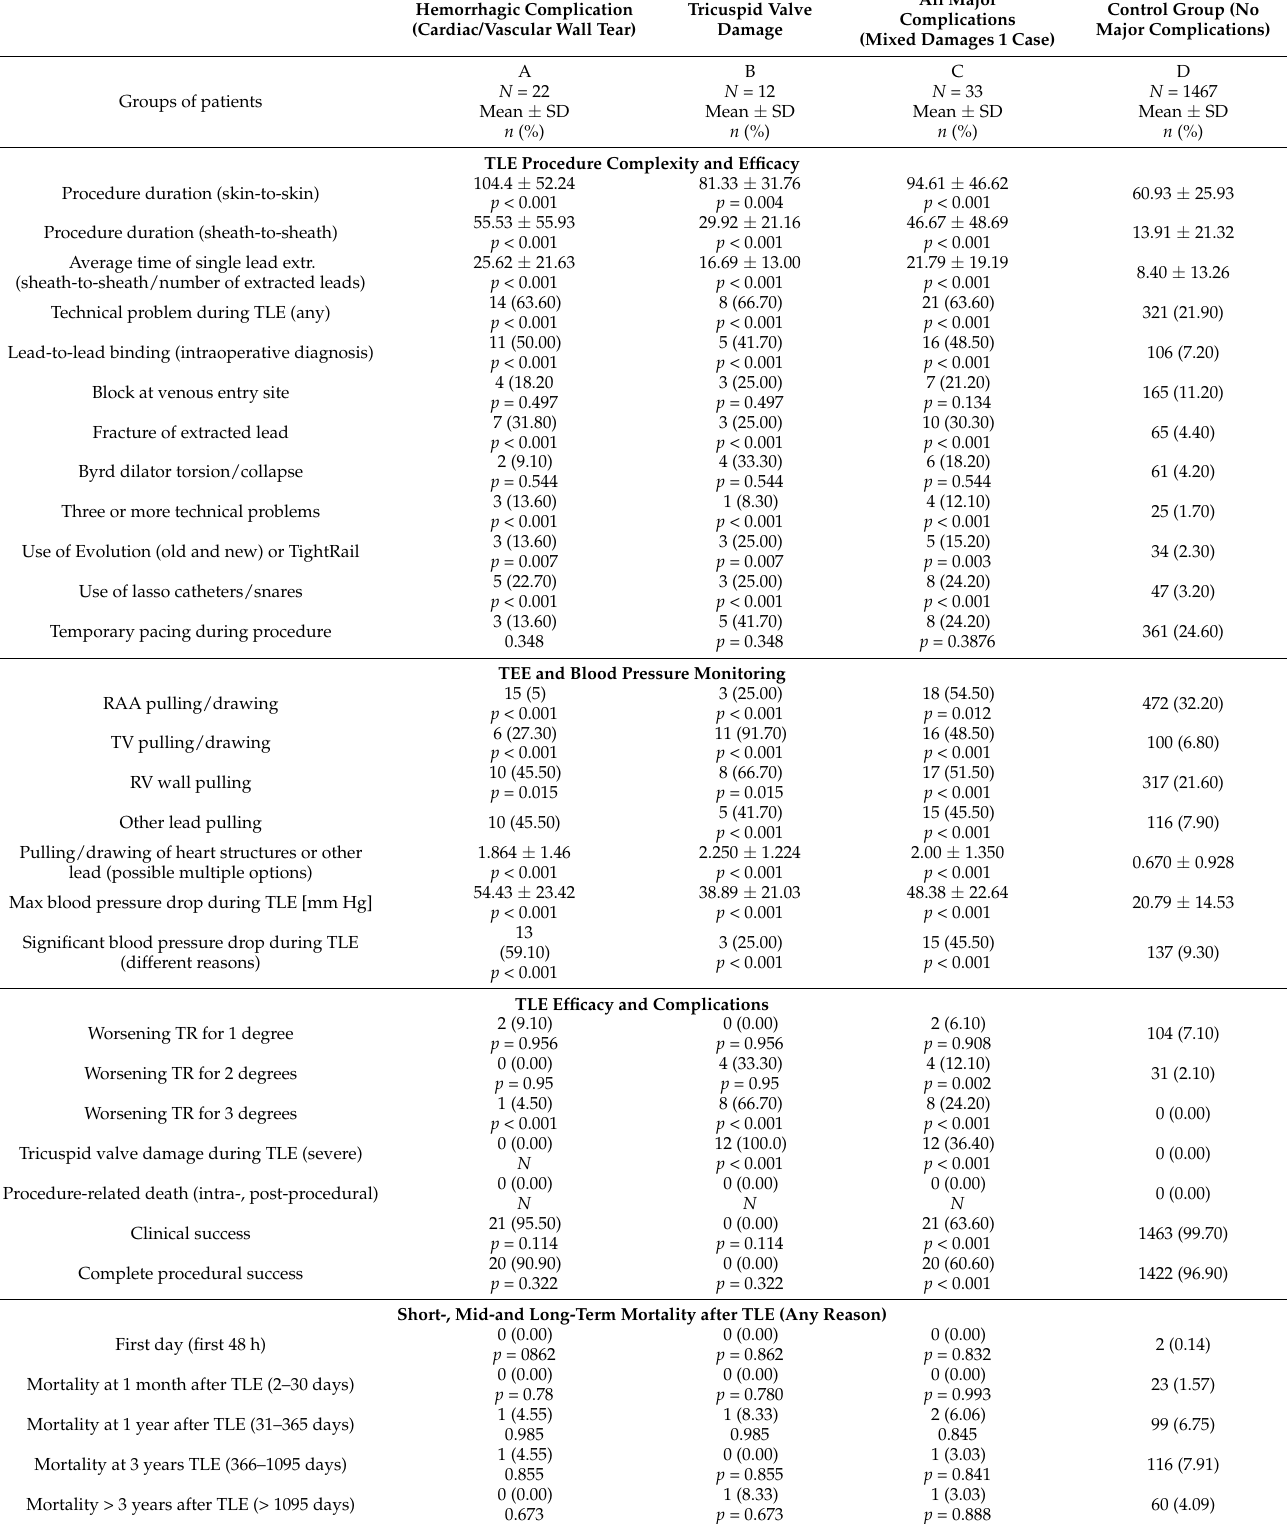
Table 4. TLE procedure complexity, efficacy, complications and mortality for any